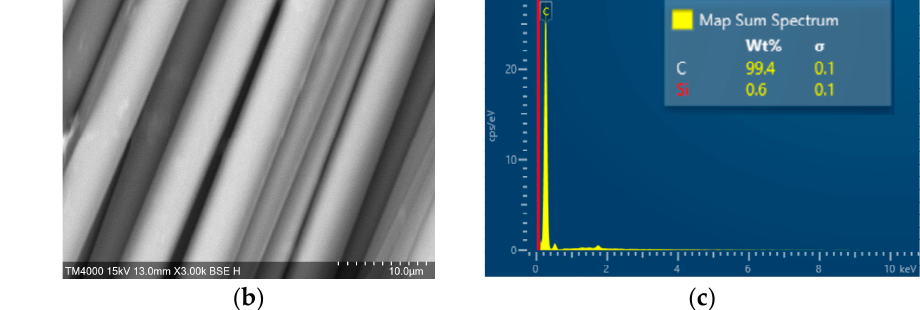
Filament data Average Figure 6. Filament tensile test results of RCF. 2.4. SEM ‐ EDS Characterization The effects of the substance on the surface of the carbon fiber on the strength of fiber ‐